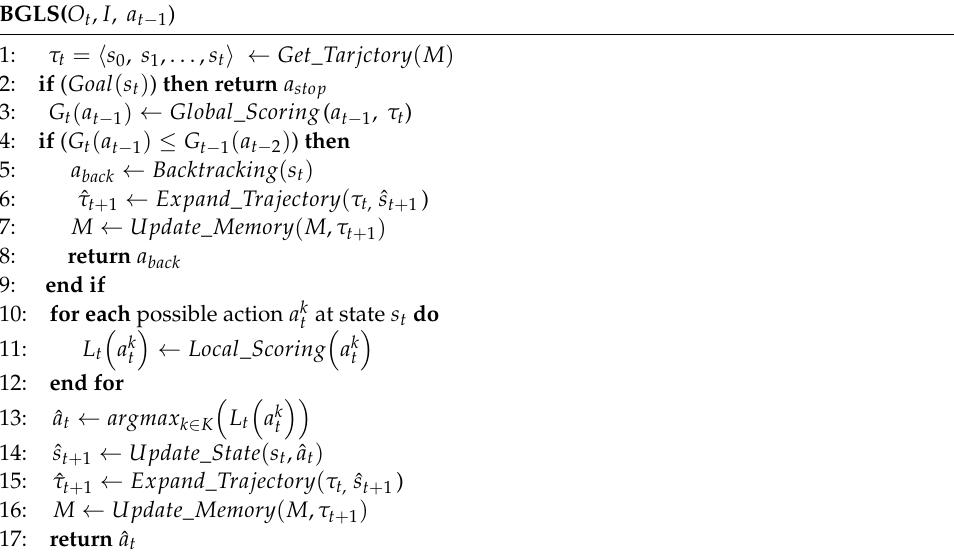
Algorithm 1. Pseudocode of backtracking-enabled greedy local search (BGLS)